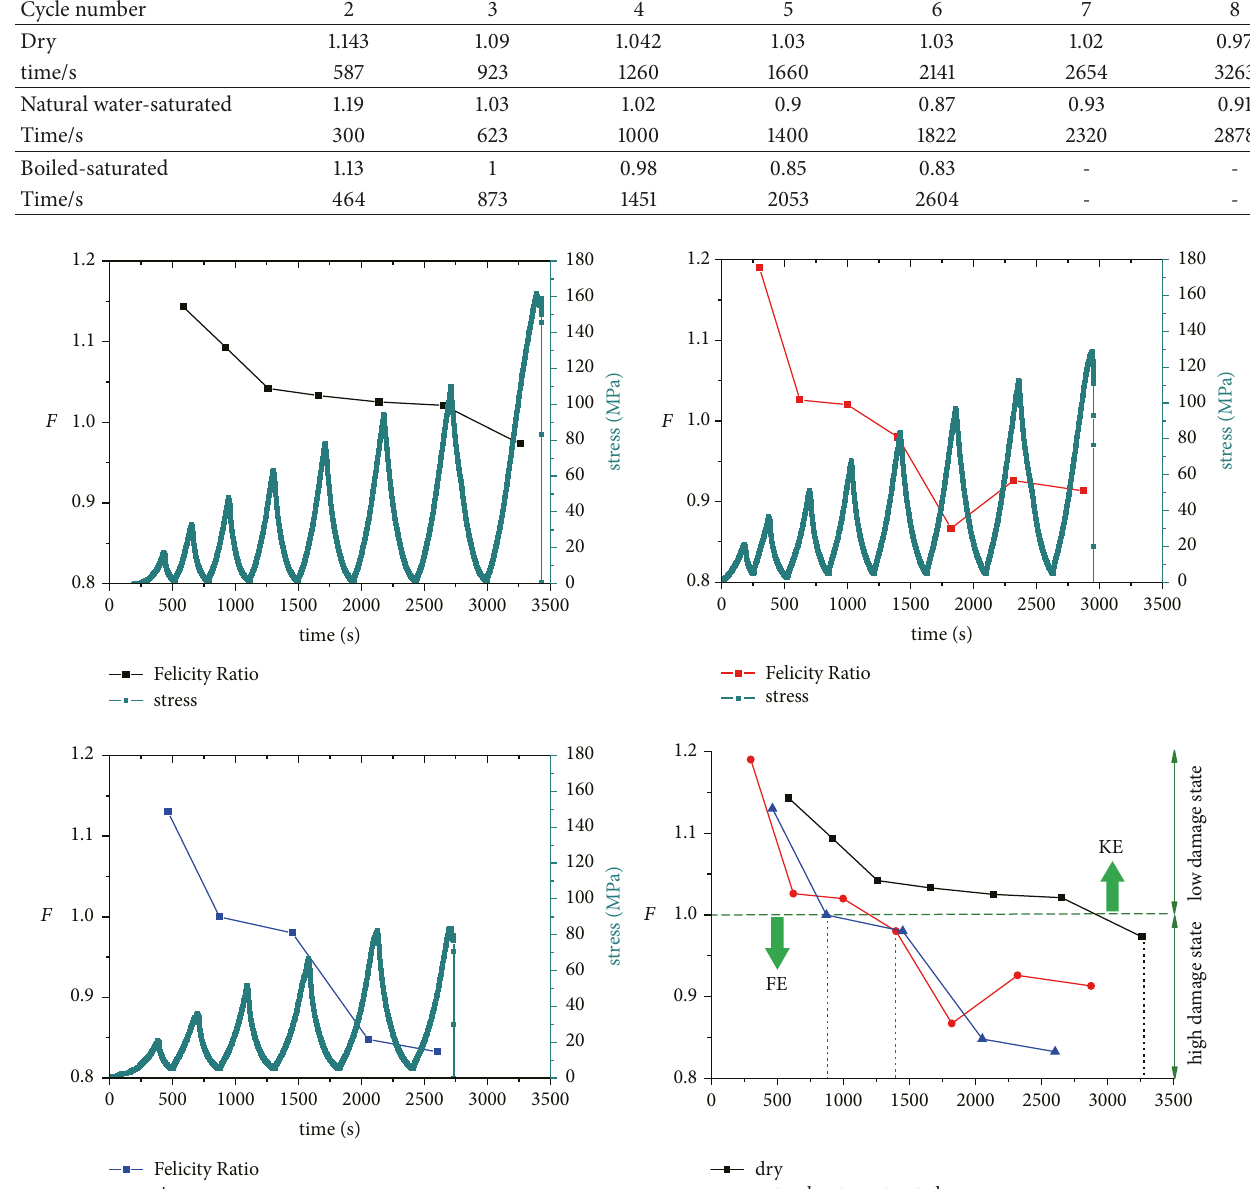
Table 3: Felicity Ratio and initial time of the AE counts in each cycle of specimens with different water contents.